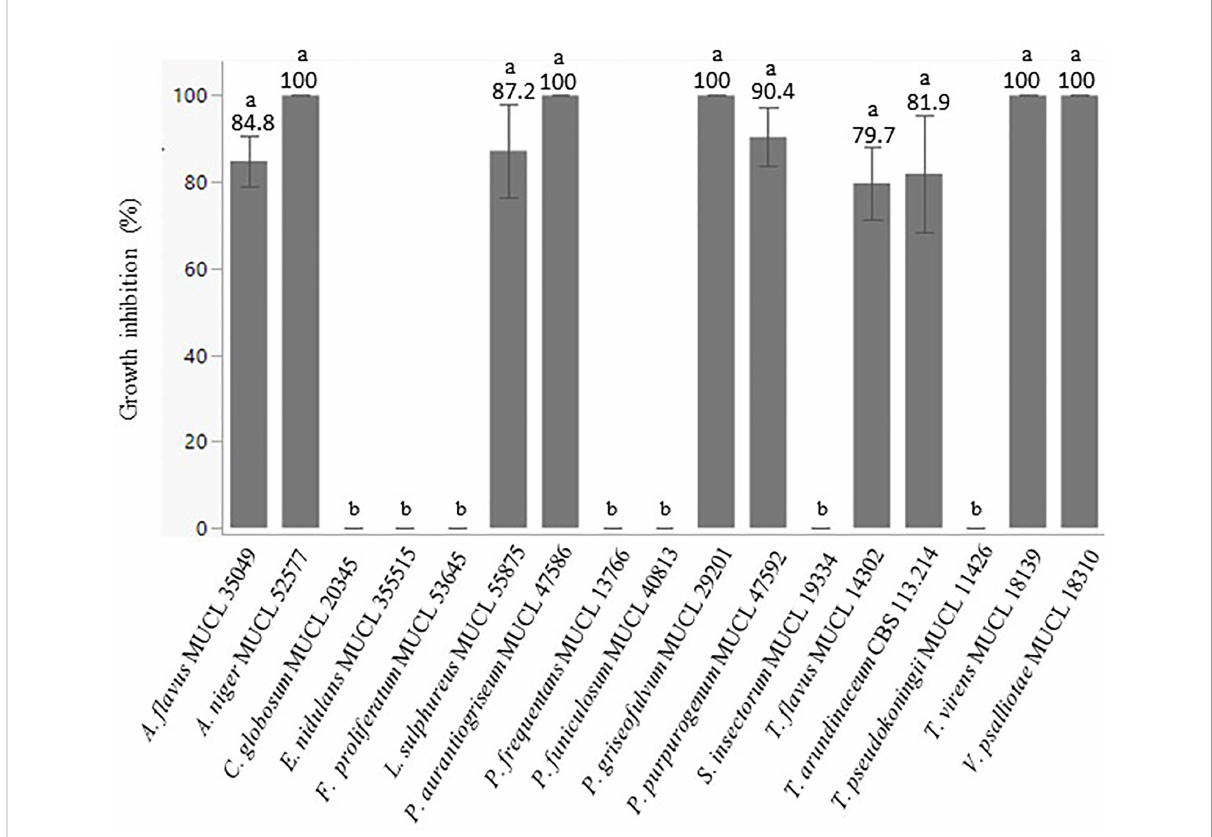
FIGURE 3 Percentage of growth inhibition of P. infestans MUCL 54981 colonies induced by culture fi ltrates of different fungal BCA candidates. Values are expressed as the mean ± SD ( n = 5). Different lowercase letters show signi fi cant differences between the treatments ( p ≤ 0.05; Dunn